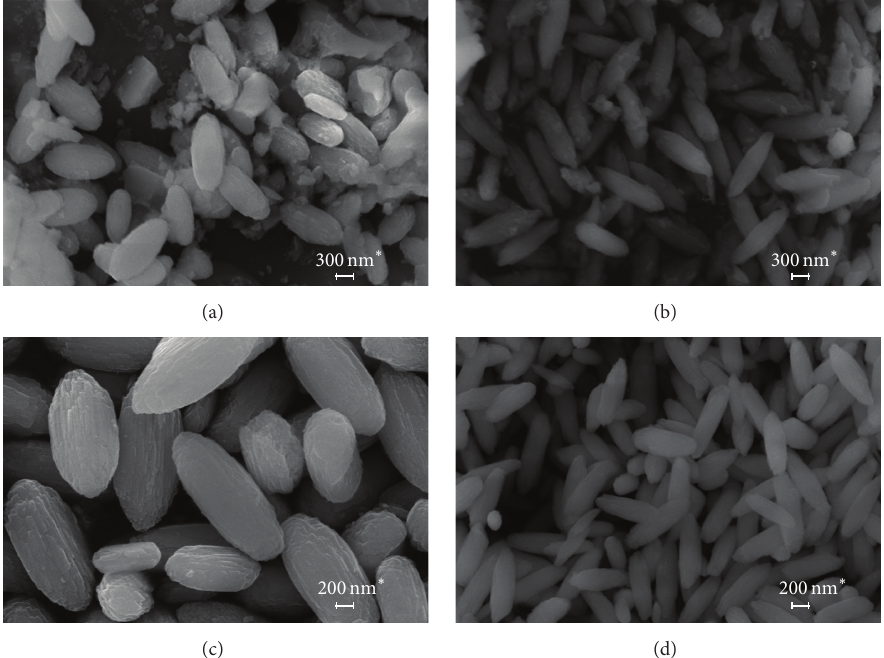
Figure 1: SEM images of GaO(OH) crystals prepared by alkali (NH 4 OH) precipitation of GaCl 3 solution at (a) pH = 4, (b) pH = 6, (c) pH = 8, and (d) pH =